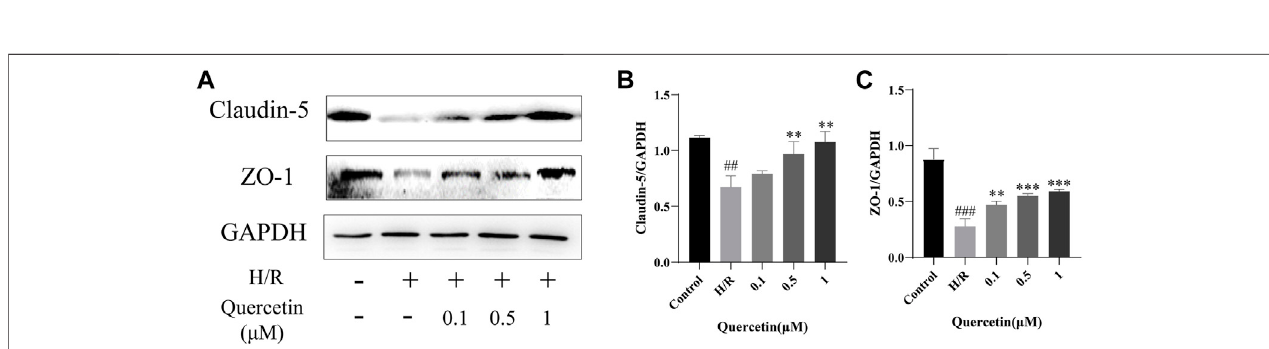
FIGURE 7 | (A) Protein expressions were evaluated with Western blotting (B) Claudin-5 quanti fi cation of Western blotting result was calculated (C) ZO-1 expression quanti fi cation of Western blotting result was inhibited. ## p < 0.01, ### p < 0.001 compared to control group; ** p < 0.01, *** p < 0.001 compared to H/R group. μ M: μ mol/L; ZO-1: Zonula occludens 1; H/R: Hypoxia and reoxygenation, n (cid:2)